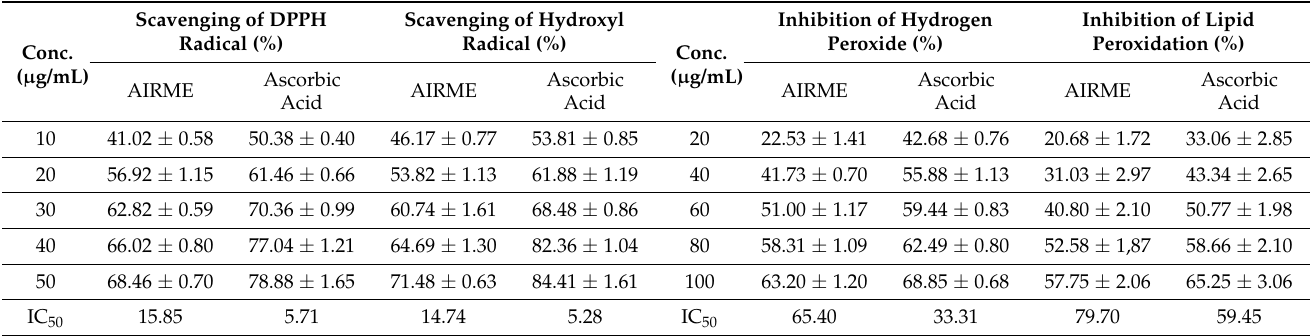
Table 2. In vitro free radical scavenging activity of AIRME. The results were compared with ascorbic acid and values represented as mean ± SD ( n = 3).